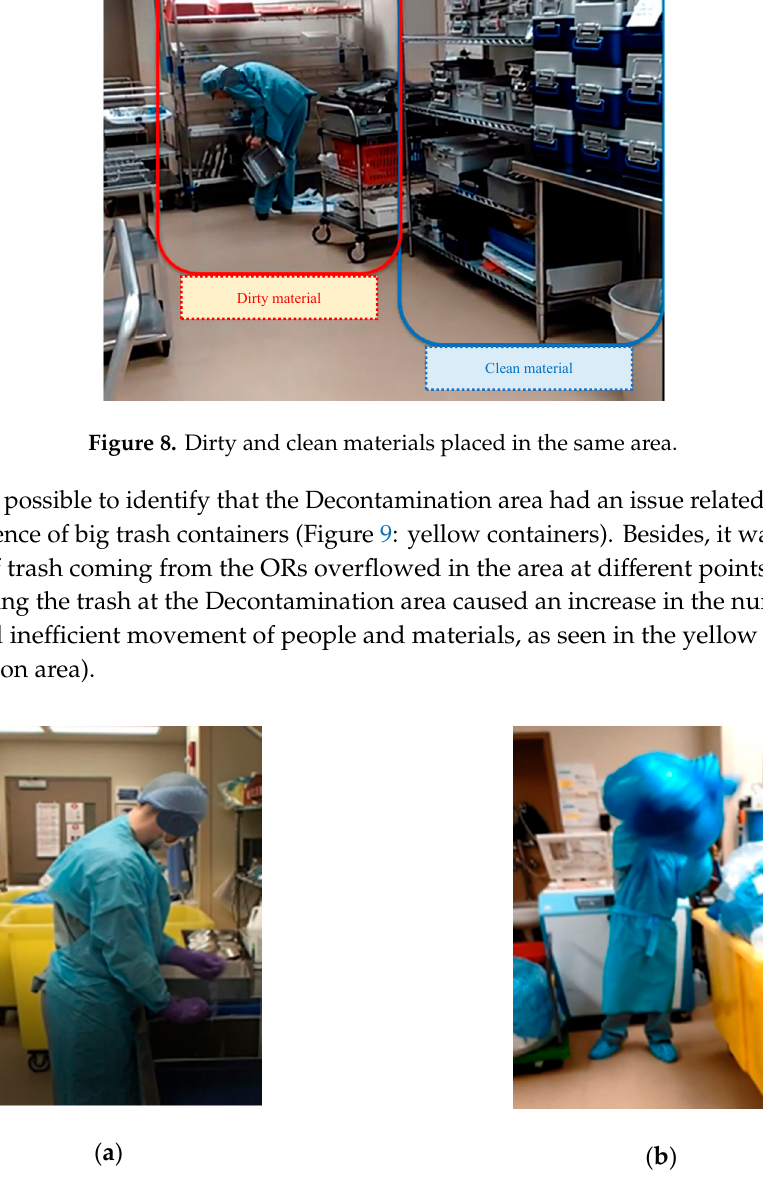
Figure 9. Handling of trash in the Decontamination area: ( a ) trash containers reducing workspace, ( b ) accumulation of trash.